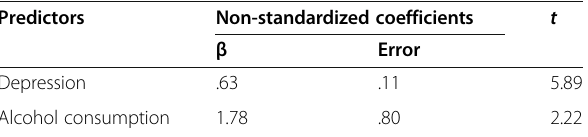
Table 5 Synthesis of the multiple regression model (enter) for anxiety.